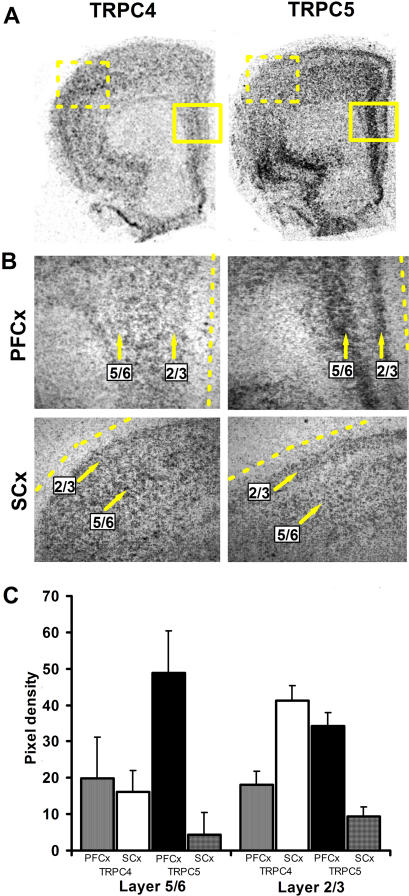
Quantification of the cRNA labelling densities of TRPC4 and 5 in the cortical layers of rat.(A) (Left) In situ hybridization of TRPC4 in a rat coronal brain slice. (Right) In situ hybridization of TRPC5 in a rat coronal brain slice. Scale bars in µm. (B) (Upper) Magnification of TRPC4 5 cRNA labeling in the PFC layers. (Lower) Magnification of TRPC4 5 cRNA labeling in the SCx layers. (C) Quantification of the cRNA labelling densities of TRPC4 and 5 in the PFC and SCx layers expressed as a % change from background (n = 3). Scale bars in µm.